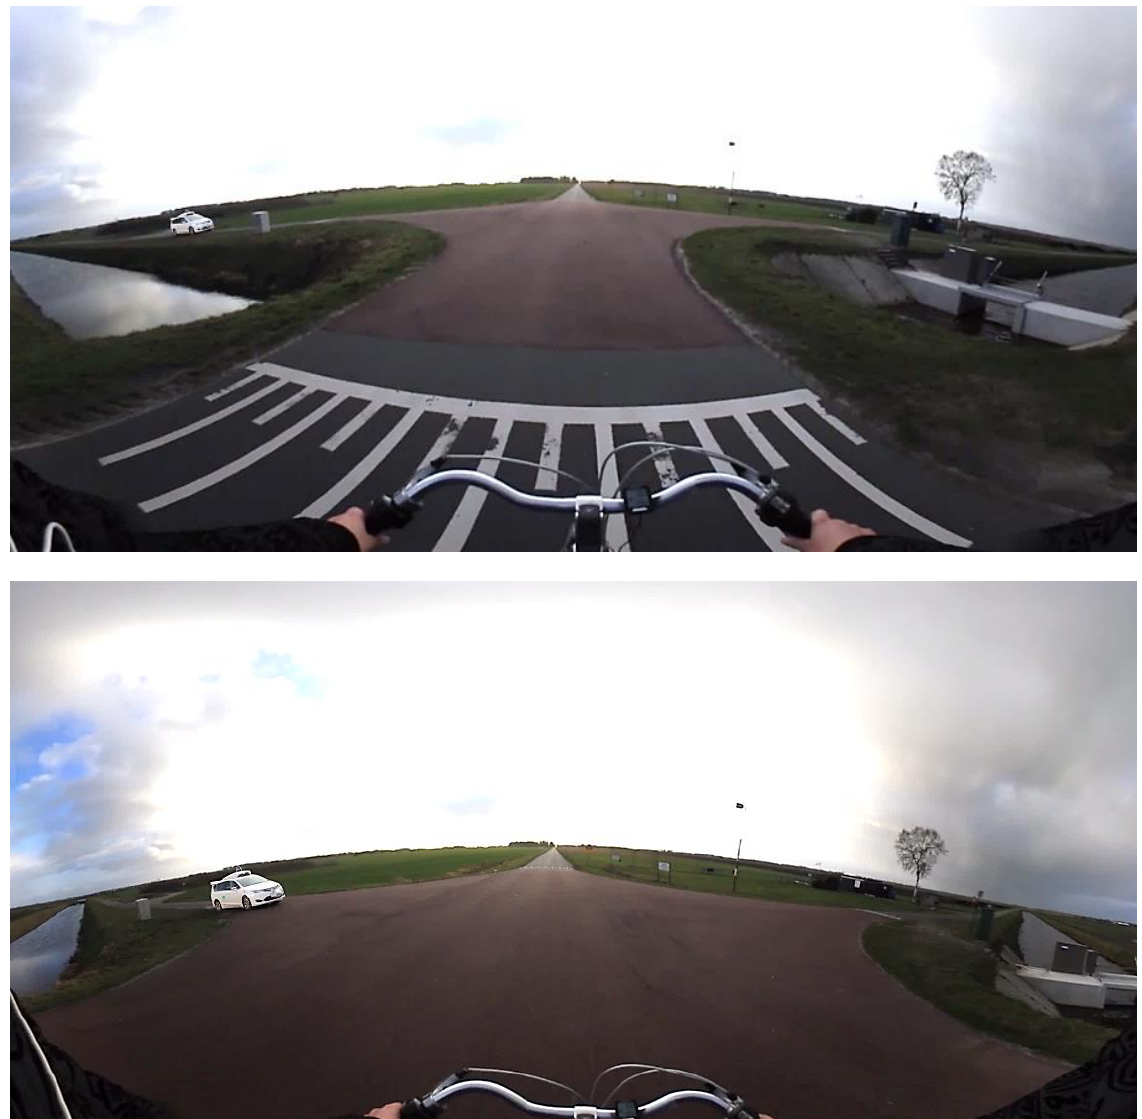
Figure 2. Screenshots of the 360° videos with the vehicle at different distances.